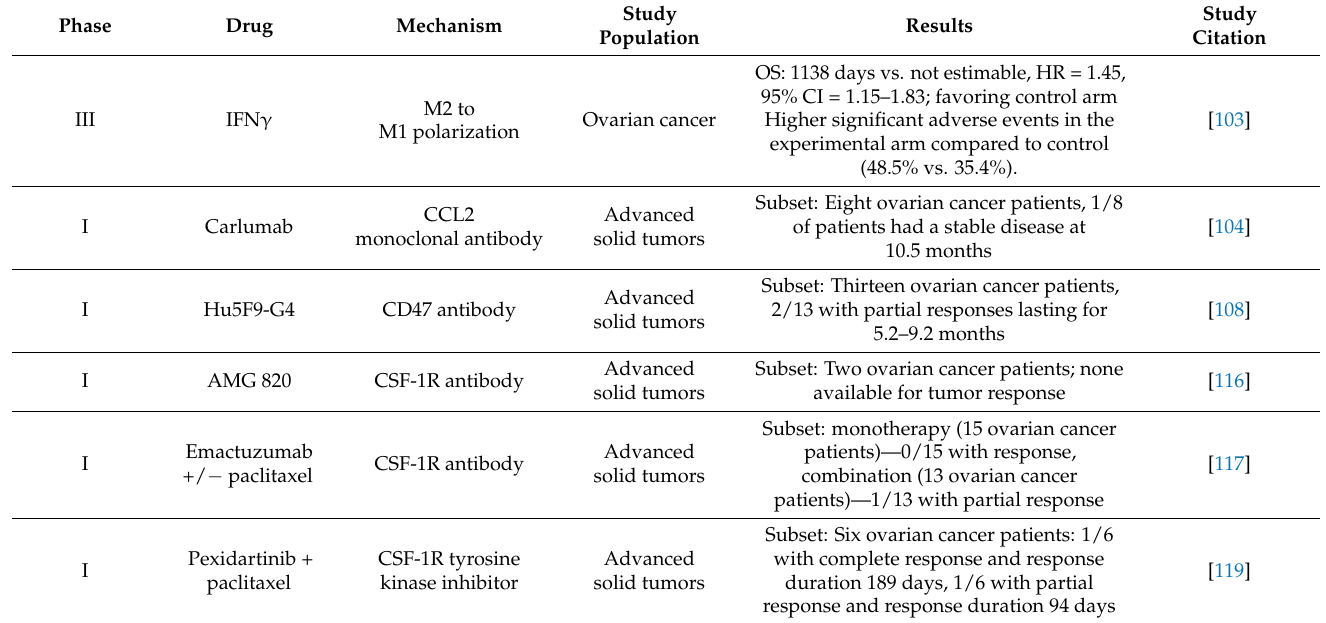
Table 2. Anti-TAM Therapeutic Clinical